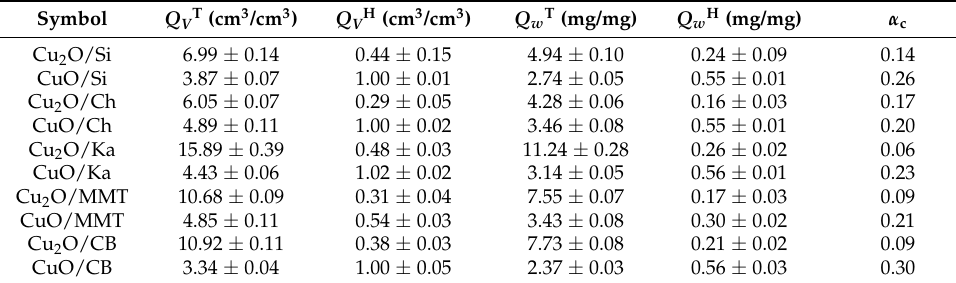
Table 3. Values of equilibrium swelling of filled CR vulcanizates; T = 160 ◦ C, t = 45